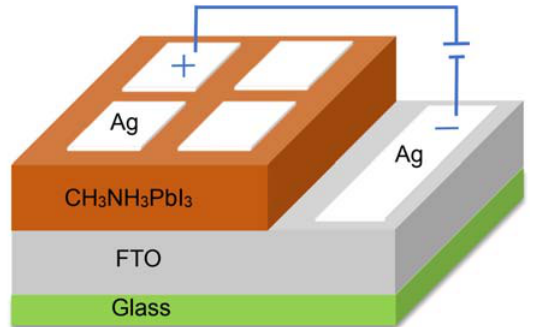
Figure 2. A schematic draw of the perovskite solar cell structure.